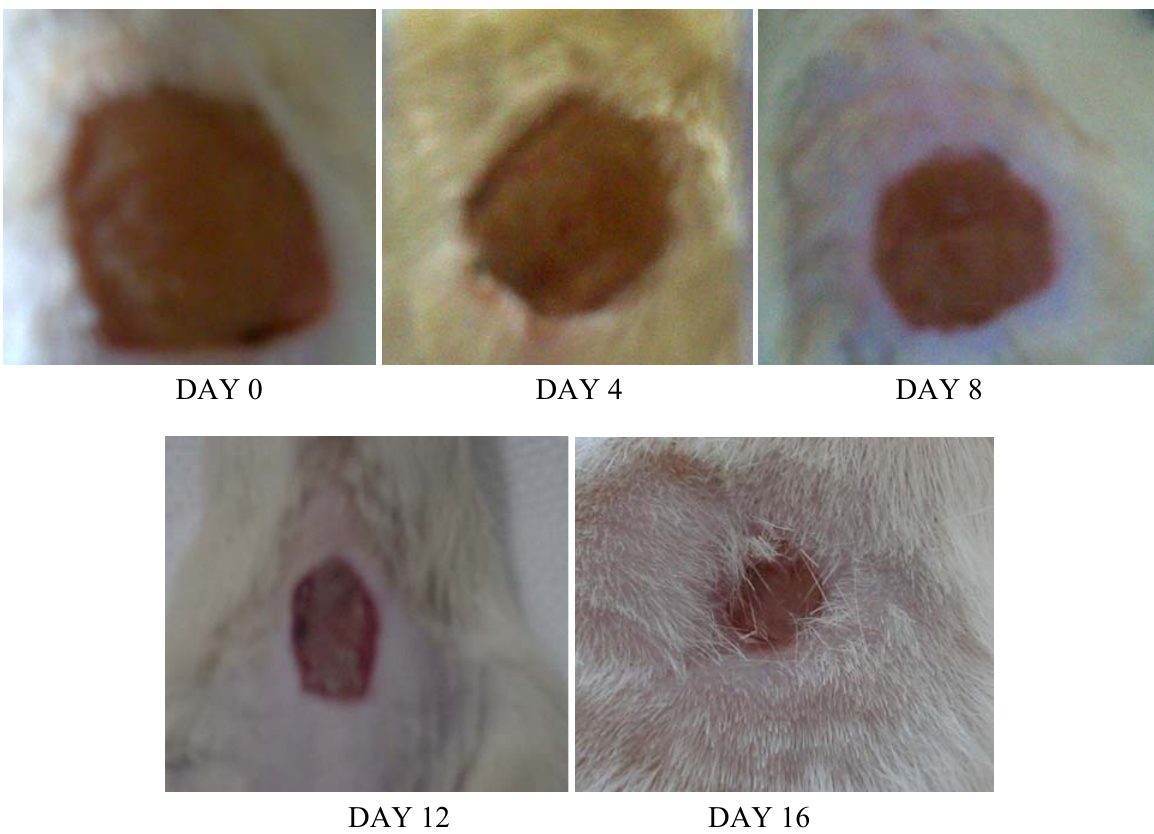
Figure 4. Photographical representation of contraction rate on different days in control group.